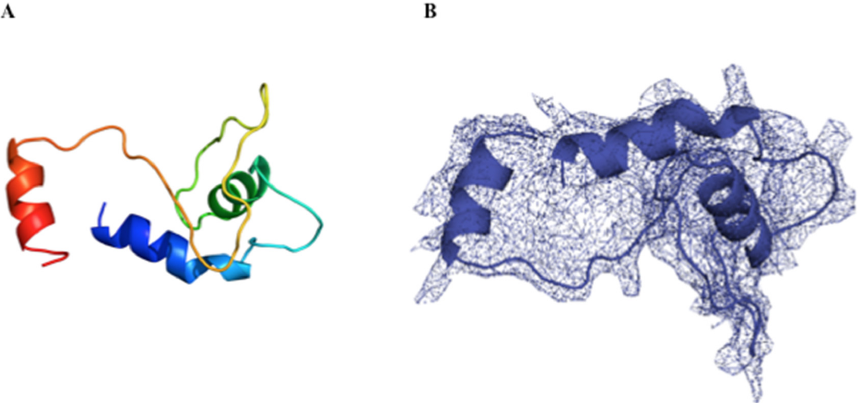
Figure 5. ( A ) Three-dimensional representation in sticks of recombinant PilS fimbriae using Jmol, a spectrum tool in the mode rainbow with the blue representing the N-terminus ascending until reaching a red color at the C-terminus; ( B ) This mesh is the prediction of the electron density map, where the protein is embedded in the